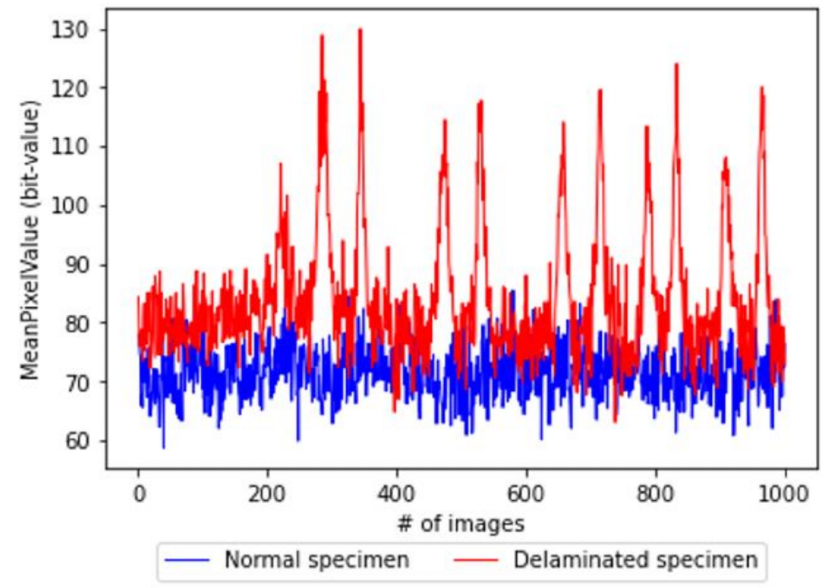
Figure 9. MPV of images obtained from the experiments. Figure 10 is a gray color image of the acquired 221st image, which was acquired in a first loading cycle. The clustered pixels showed the light emission